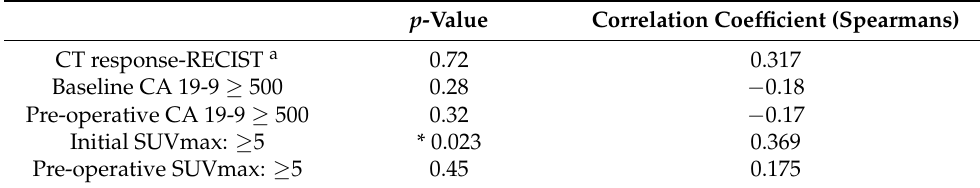
Table 3. Biological and radiological predictors for tumor regression (tumor viability). p